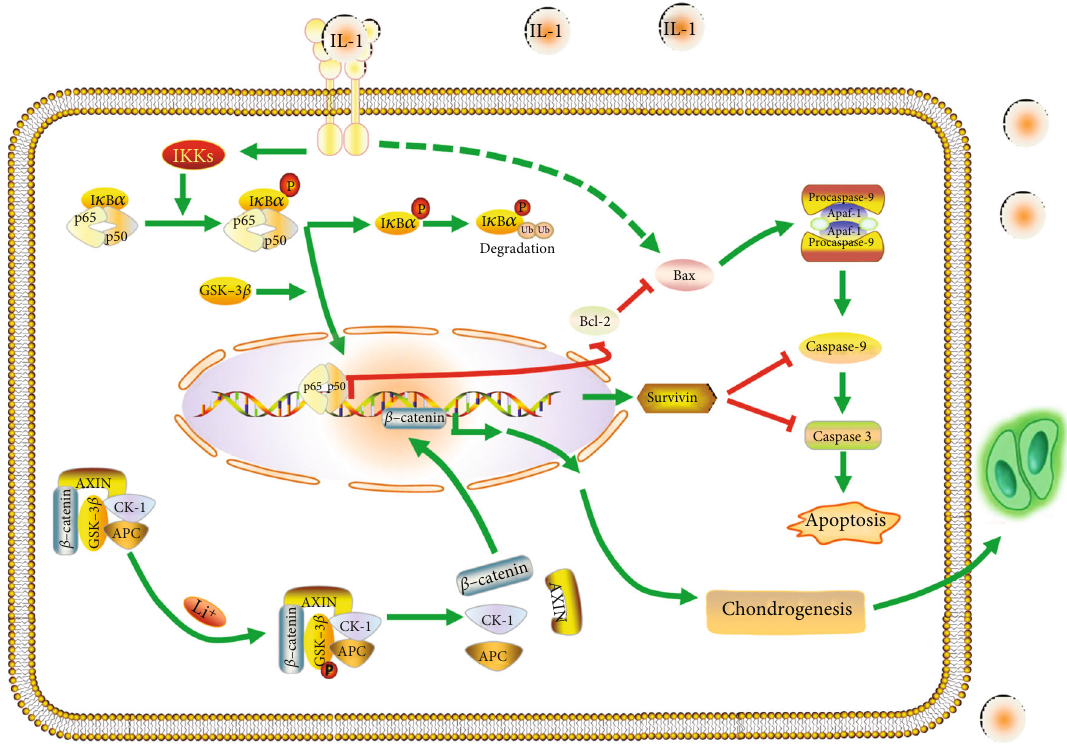
Figure 7: Schematic diagram of the mechanisms. GSK-3 β regulates the chondrogenesis via NF- κ B signaling and Wnt/ β -catenin signaling and possibly mediates the cross-reaction between NF- κ B and β -catenin in the